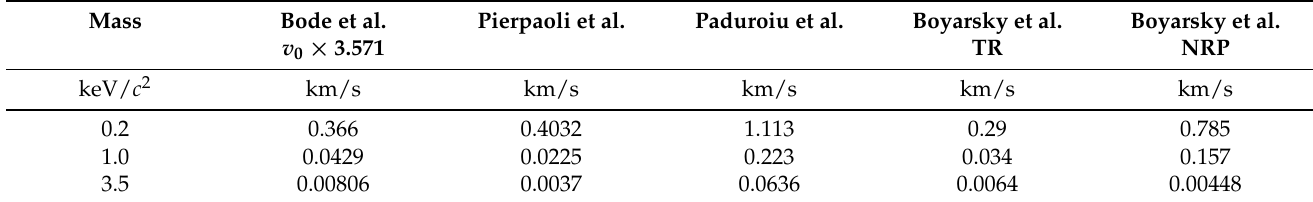
Table 1. The mass-velocity dispersion relation found in the literature for 0.2, 1 and 3.5 keV. The first column shows the value originally given in [19]—note that while in the table the velocity is calculated using the 3.571 value for the rms velocity factor, as usually found in the literature, the rms value should be 3.5971 instead, as shown in [16]; the second column shows the value obtained using g dec = 150 [27] in Equation (6); the third one, the value given by Equation (14) ([16]); and the fourth and fifth, the value given by [35] for thermal and non-resonant produced neutrinos, respectively. All the values are given at redshift z =